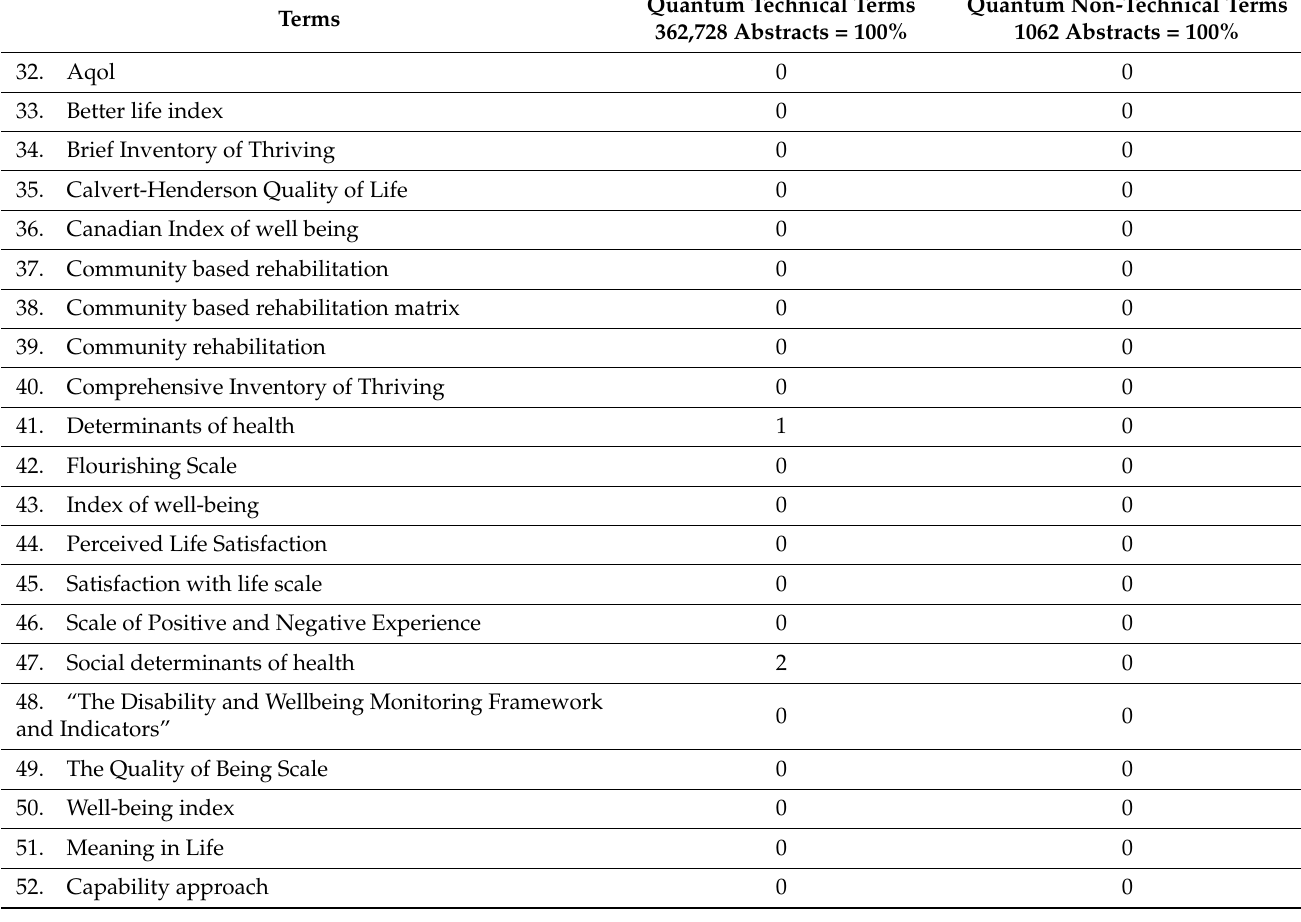
Table 4. Hit counts for the terms used for the various “measures” [9–39] in conjunction with quantum terms covered.